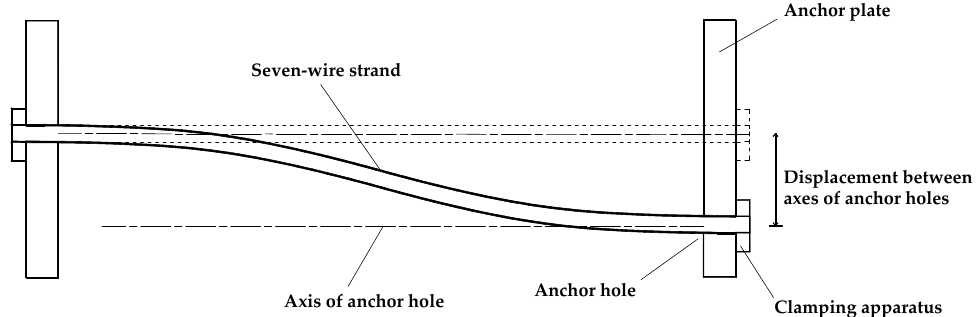
Figure 16. Lateral bending of the seven-wire strands in the test.